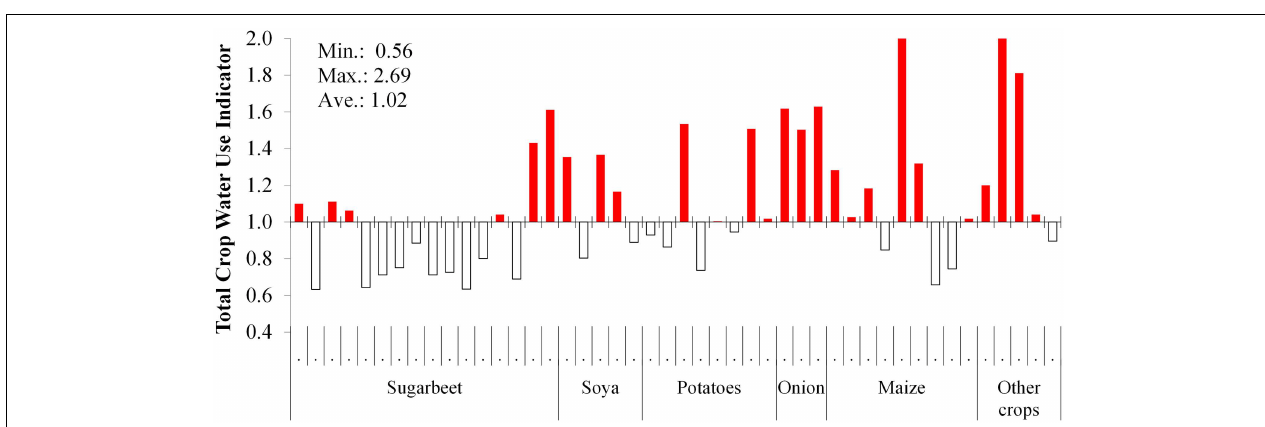
FIGURE 6 | Total Crop Water Use Indicator (Water supply/Potential Water Demand) for Sugarbeet ( n = 16 ), Soya ( n = 5 ), Potatoes ( n = 8 ), Onion ( n = 3 ), Maize ( n = 9 ), and other crops ( n = 5 ).